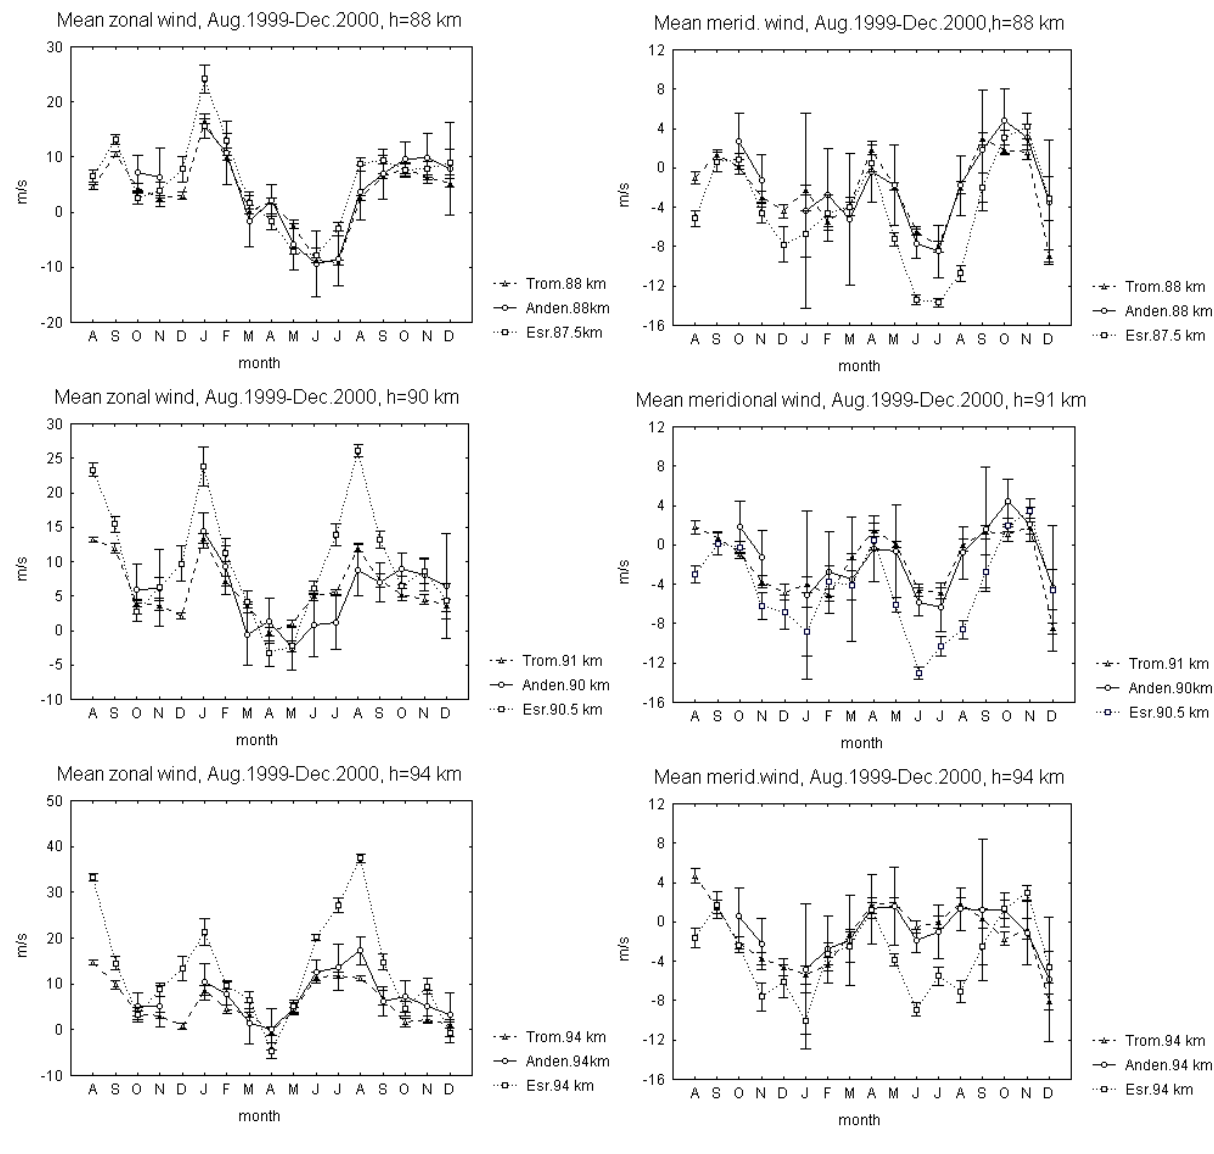
Fig. 1. ( a ) Monthly mean zonal wind measured at “Scandinavian triangle”. ( b ) Monthly mean meridional wind measured at “Scandinavian